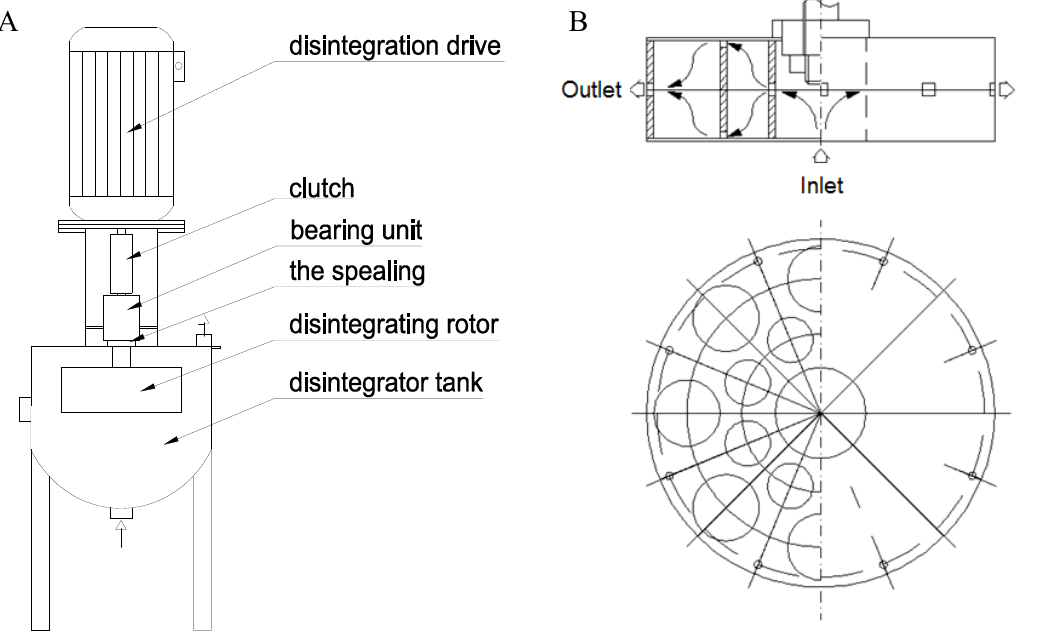
Figure 1. The scheme of the hydrodynamic cavitator ( A ) and cavitation head ( B ).